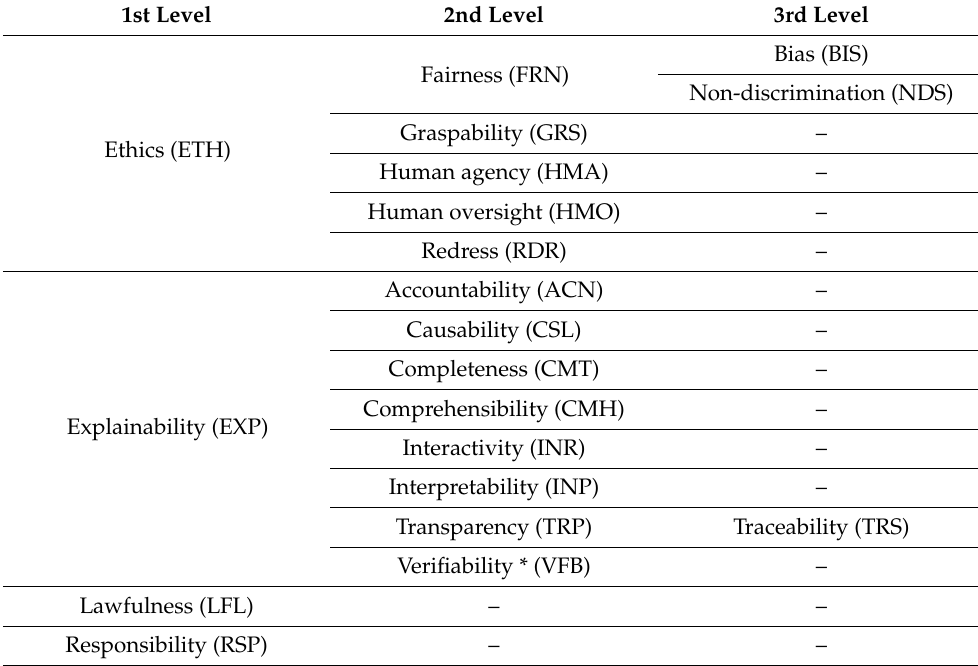
Table 5. The tabular representation of the AI quality model QS ChAI